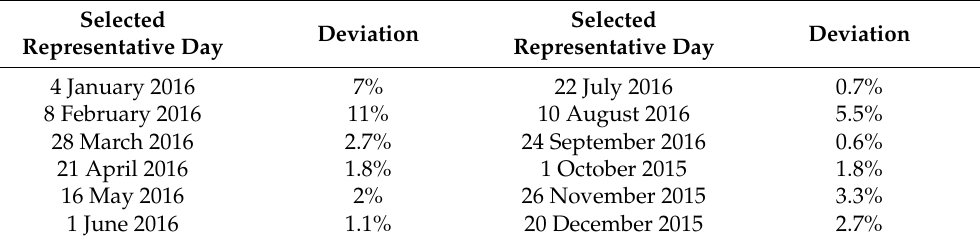
Table 2. Selected representative days for the city of Thessaloniki and the corresponding air tempera- ture (Tair) deviations from the respective long-term median values.